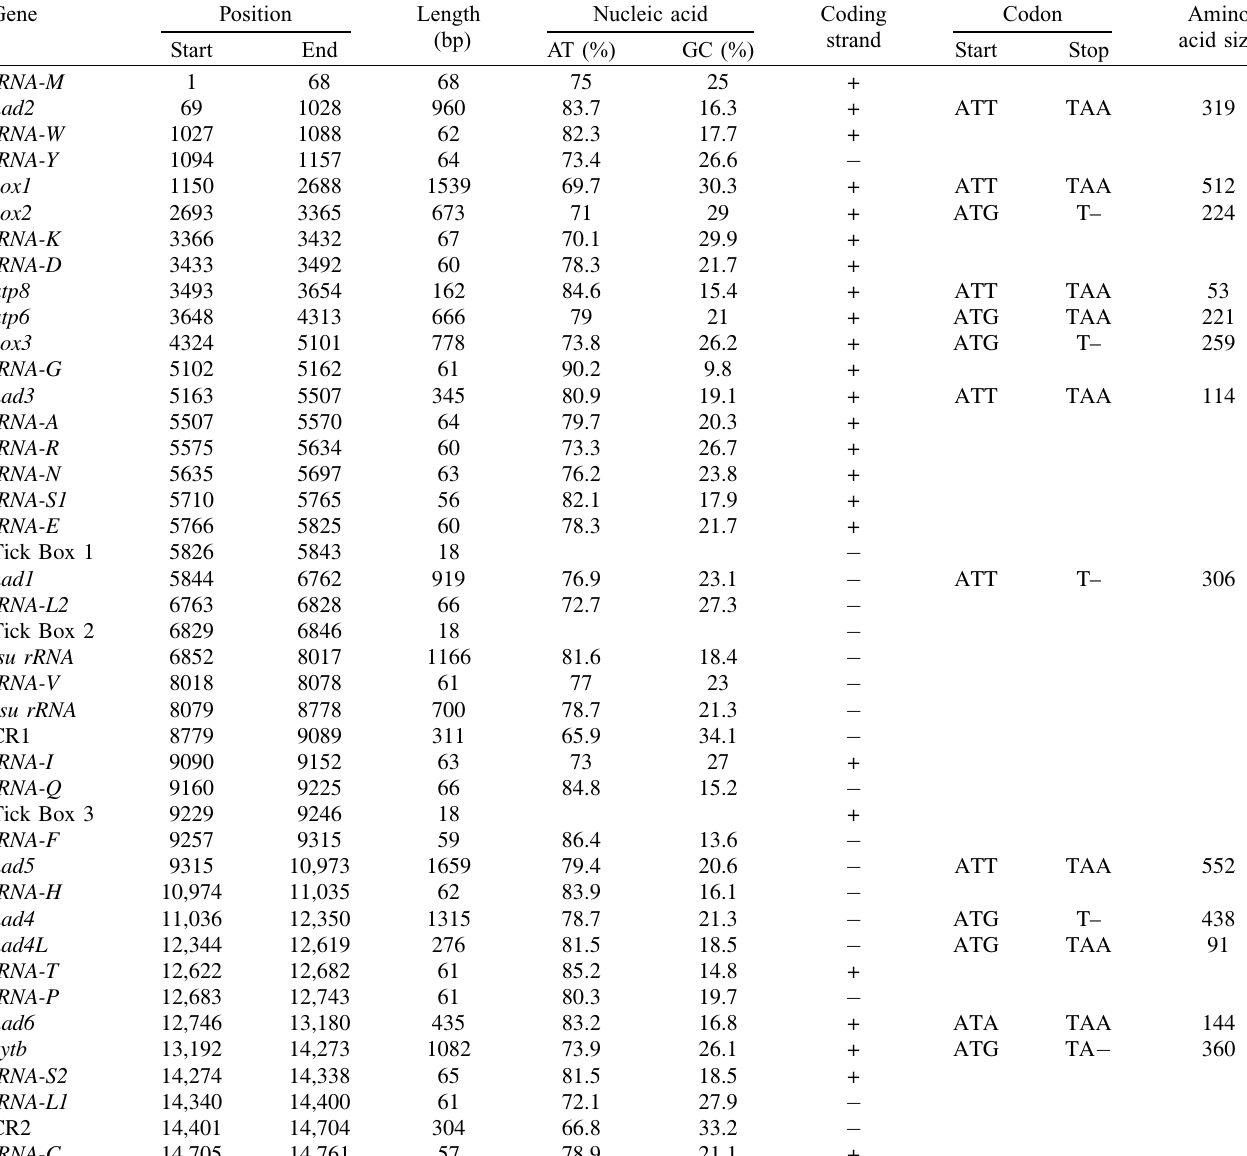
Table 1. Mitochondrial genome organisation of Dermacentor auratus with gene order, positions, lengths, nucleic acid composition, coding strand, and start and stop